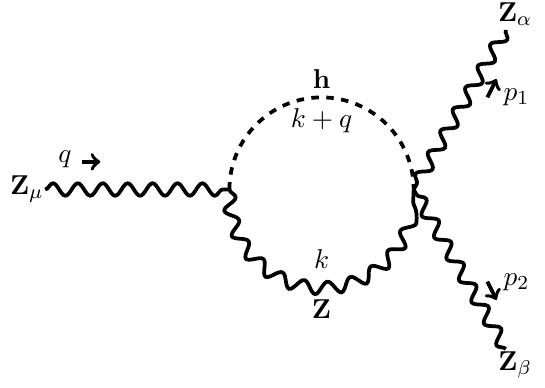
Figure 8 . A one-loop diagram contributing to the Z 3 vertex in the EFT. There are two other diagrams corresponding to permutations of the external